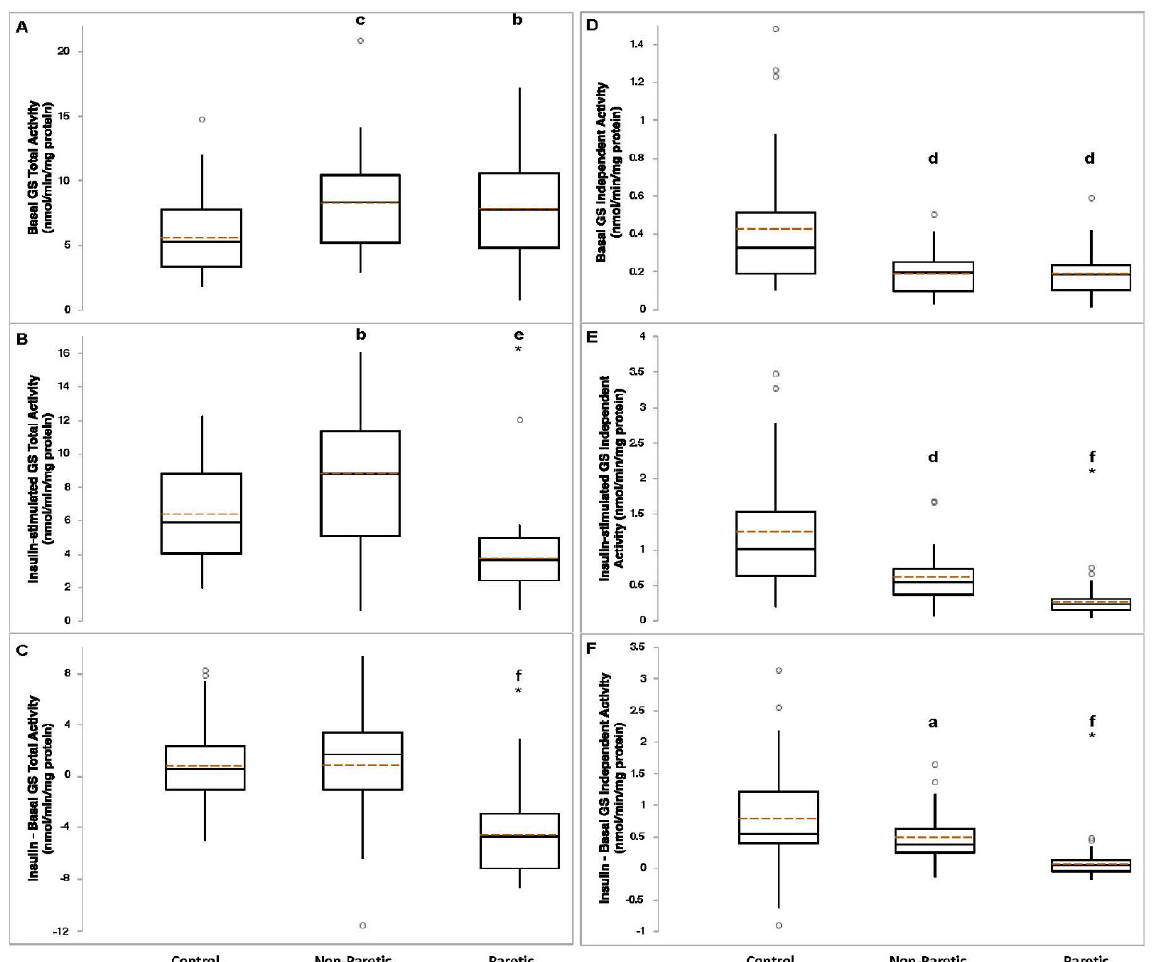
Figure 1. Basal panel ( A ), insulin-stimulated panel ( B ), and absolute change (insulin-stimulated minus basal, panel ( C ) glycogen synthase (GS) independent activities in control ( n = 34–35), nonparetic ( n = 24–28), and paretic ( n = 26–29) muscle samples). Basal panel ( D ), insulin-stimulated panel ( E ), and absolute change panel ( F ) GS total activities in control ( n = 33– 35), nonparetic ( n = 26–28), and paretic ( n = 27–29) muscle samples. Boxplot legend: height of box = interquartile range (IQR); top of box = the 75th percentile (Q3); bottom of box = the 25th percentile (Q1); solid center line = median; dashed red line = mean; vertical line = range of data; open circles = outliers (< Q1-[1.5*IQR] or > Q3+[1.5*IQR]). Classical ANOVA with Fisher pairwise probabilities panels ( A , C ); Welch’s ANOVA with Welsh’s pairwise probabilities panels ( B , D – F ). a, p < 0.05; b, p = 0.01; c, p < 0.005; d, p < 0.0005; e, p < 0.0001; f, p < 0.00001 compared to control. * significantly different from nonparetic, p < 0.0005.